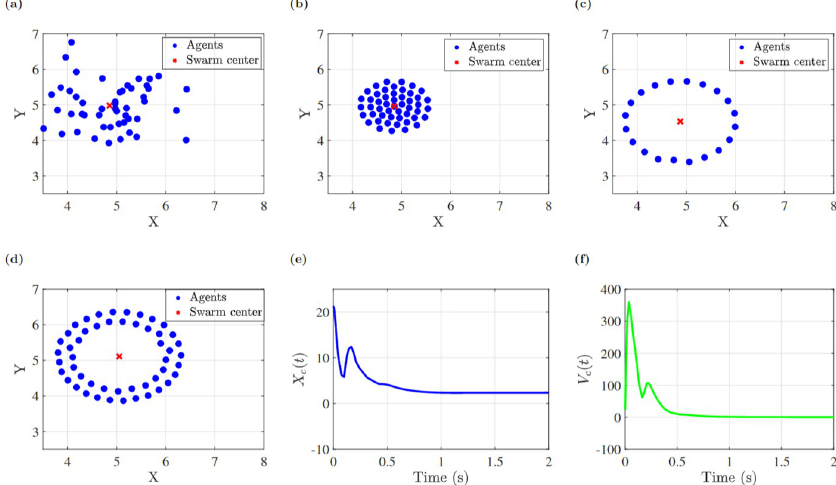
Fig 9. (a) Initial position of agents, (b) cluster shape, (c) ring shape, (d) double ring shape, (e) and (f) consensus of position and velocity for